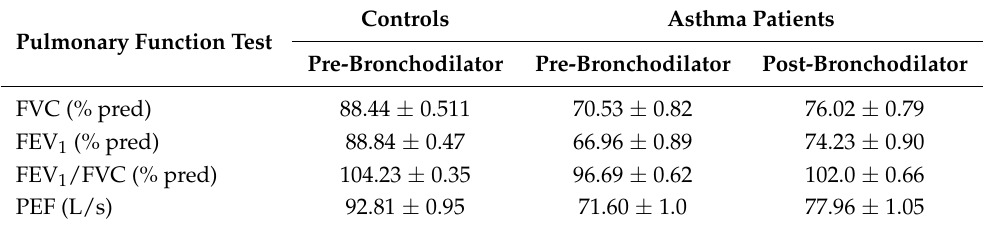
Table 2. Lung function profile of study